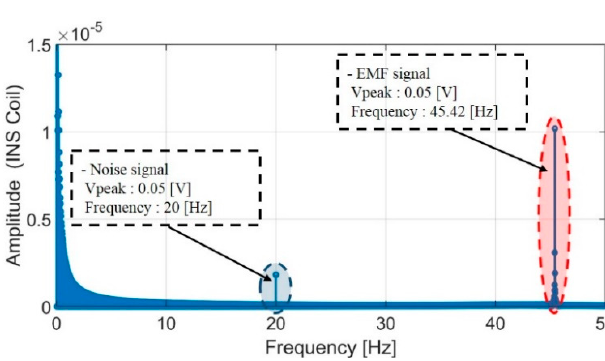
Figure 5. FFT analysis results using the insulated (INS) coil.